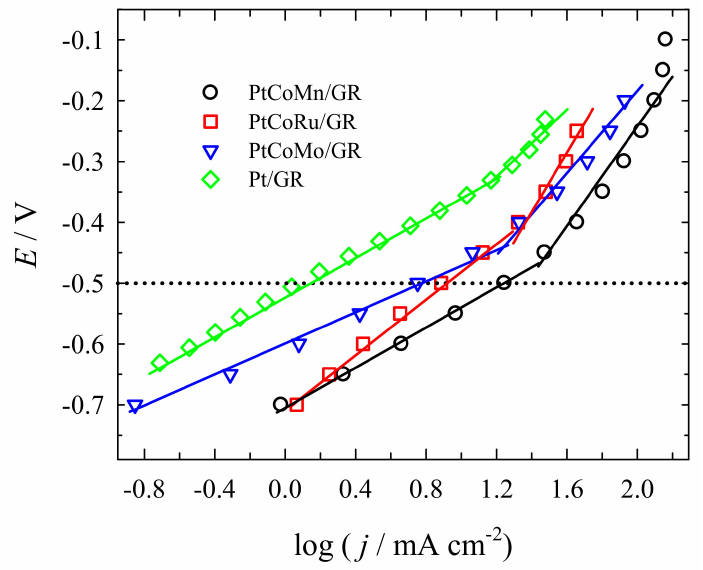
Figure 7. Tafel plots for oxidation of methanol on various electrocatalysts in a 1 M CH 3 OH + 1 M NaOH